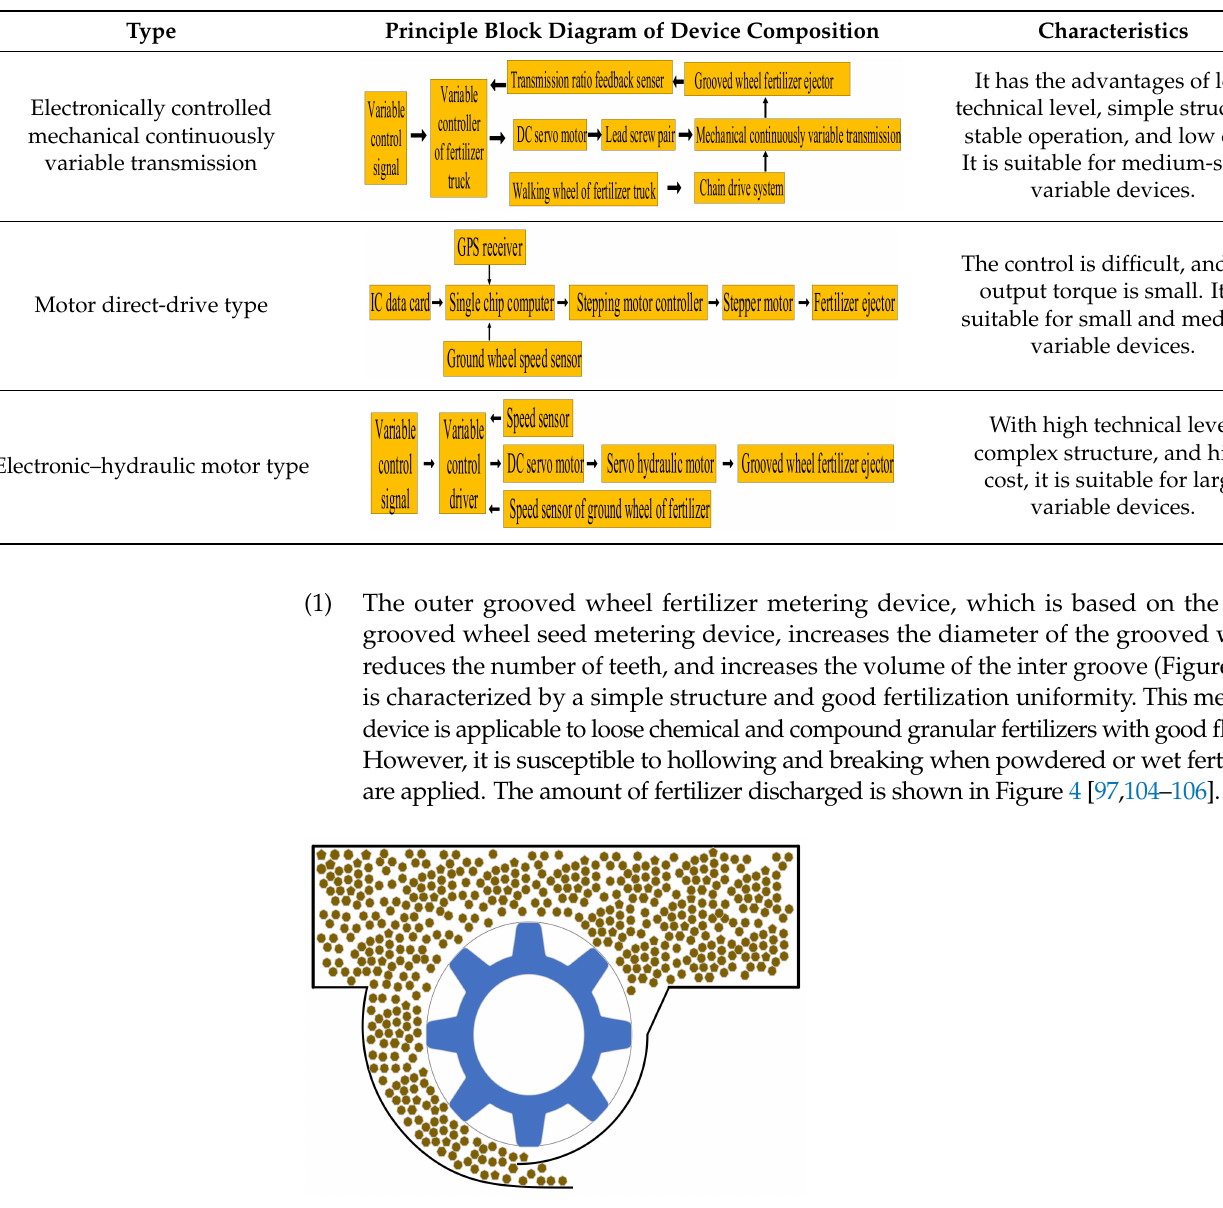
Table 4. Variable rate fertilization mechanisms with different driving types.